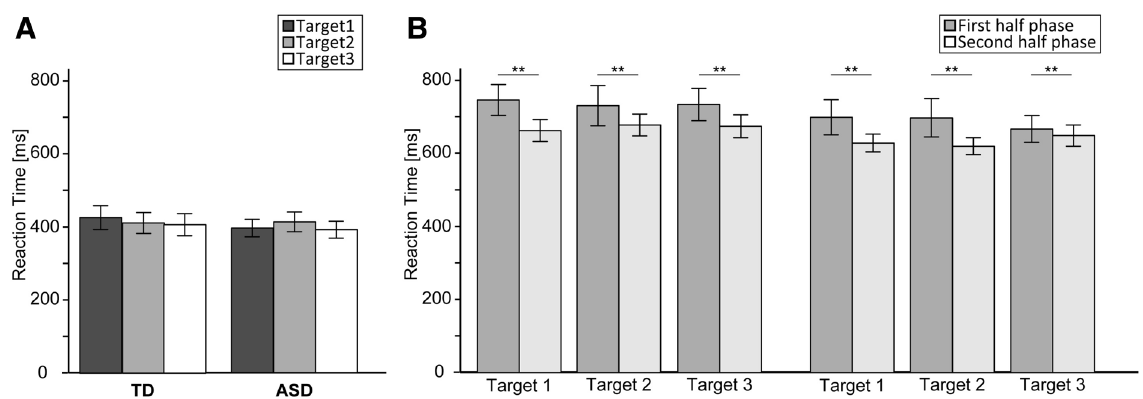
Figure 2. The RT (ms) in both the TD and ASD groups for both the Baseline task ( A ) and Perspective- transformed task ( B ). Error bars indicate standard errors of the mean. Reaction time (RT); Typically developing group (TD); Autism Spectrum Disorder group (ASD). ** p <